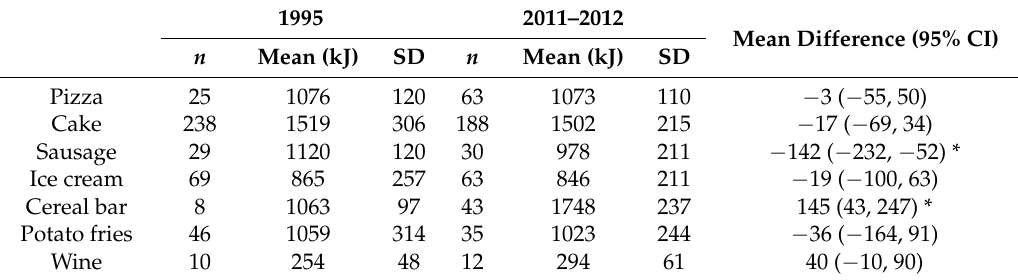
Table 3. Comparison of average energy density (energy per 100 g) of key discretionary food categories that demonstrated ≥ 15% difference in typical portion size (kJ) between 1995 and